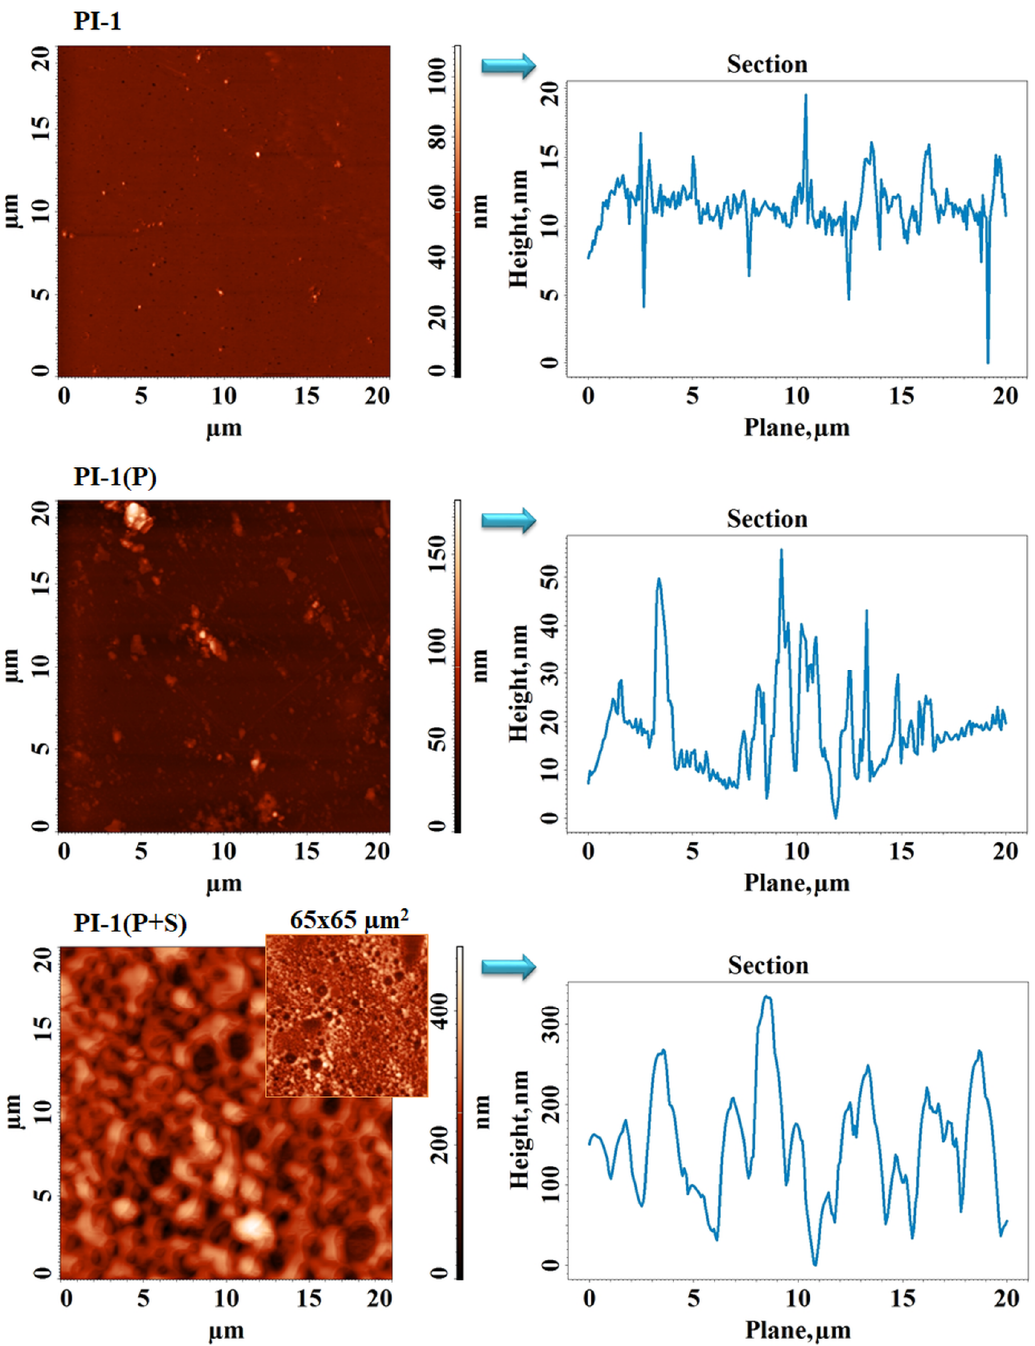
Figure 8. The AFM images and corresponding average cross-section profiles collected for the sample PI-1 before and after the DCSBD plasma treatment (P) and DCSBD plasma treatment followed by spraying